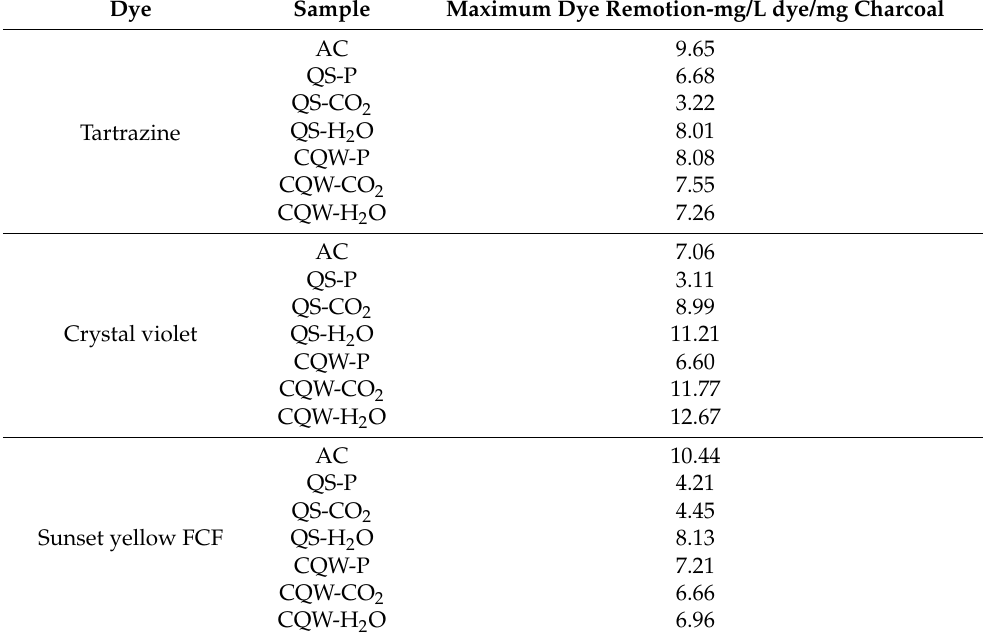
Table 4. Comparison between the capture capabilities of the different types of charcoal for dye solutions. Dye Sample Maximum Dye Remotion-mg/L dye/mg